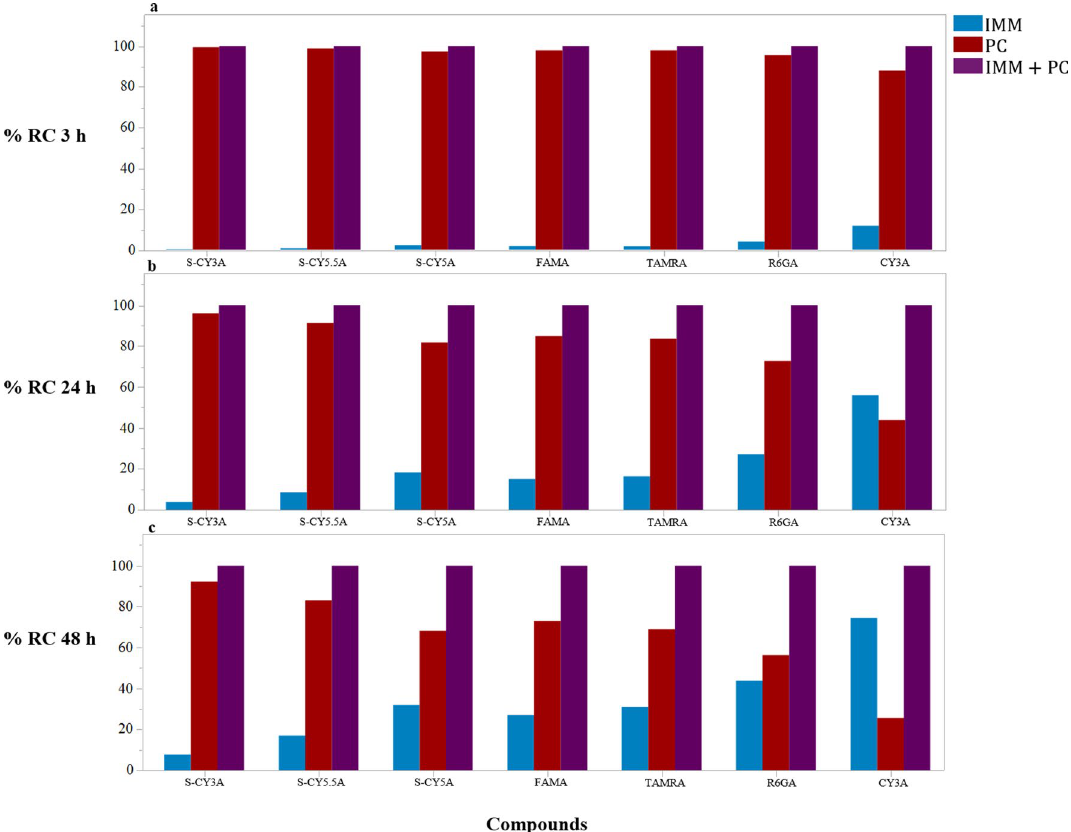
Figure 11. Histograms of Relative AUC contribution ( RC h ) of the immersion and PC exposure route as compared to AUC obtained after combination treatment for a 3 h treatment ( a ), 24 h treatment ( b ) and a 48 h treatment ( b ). The image was produced using JMP (version 15.1. SAS Institute Inc., Cary, NC, 2019) and arranged in GIMP (version 2.10.24 https:// www. gimp. org/ 2021) Software. PK